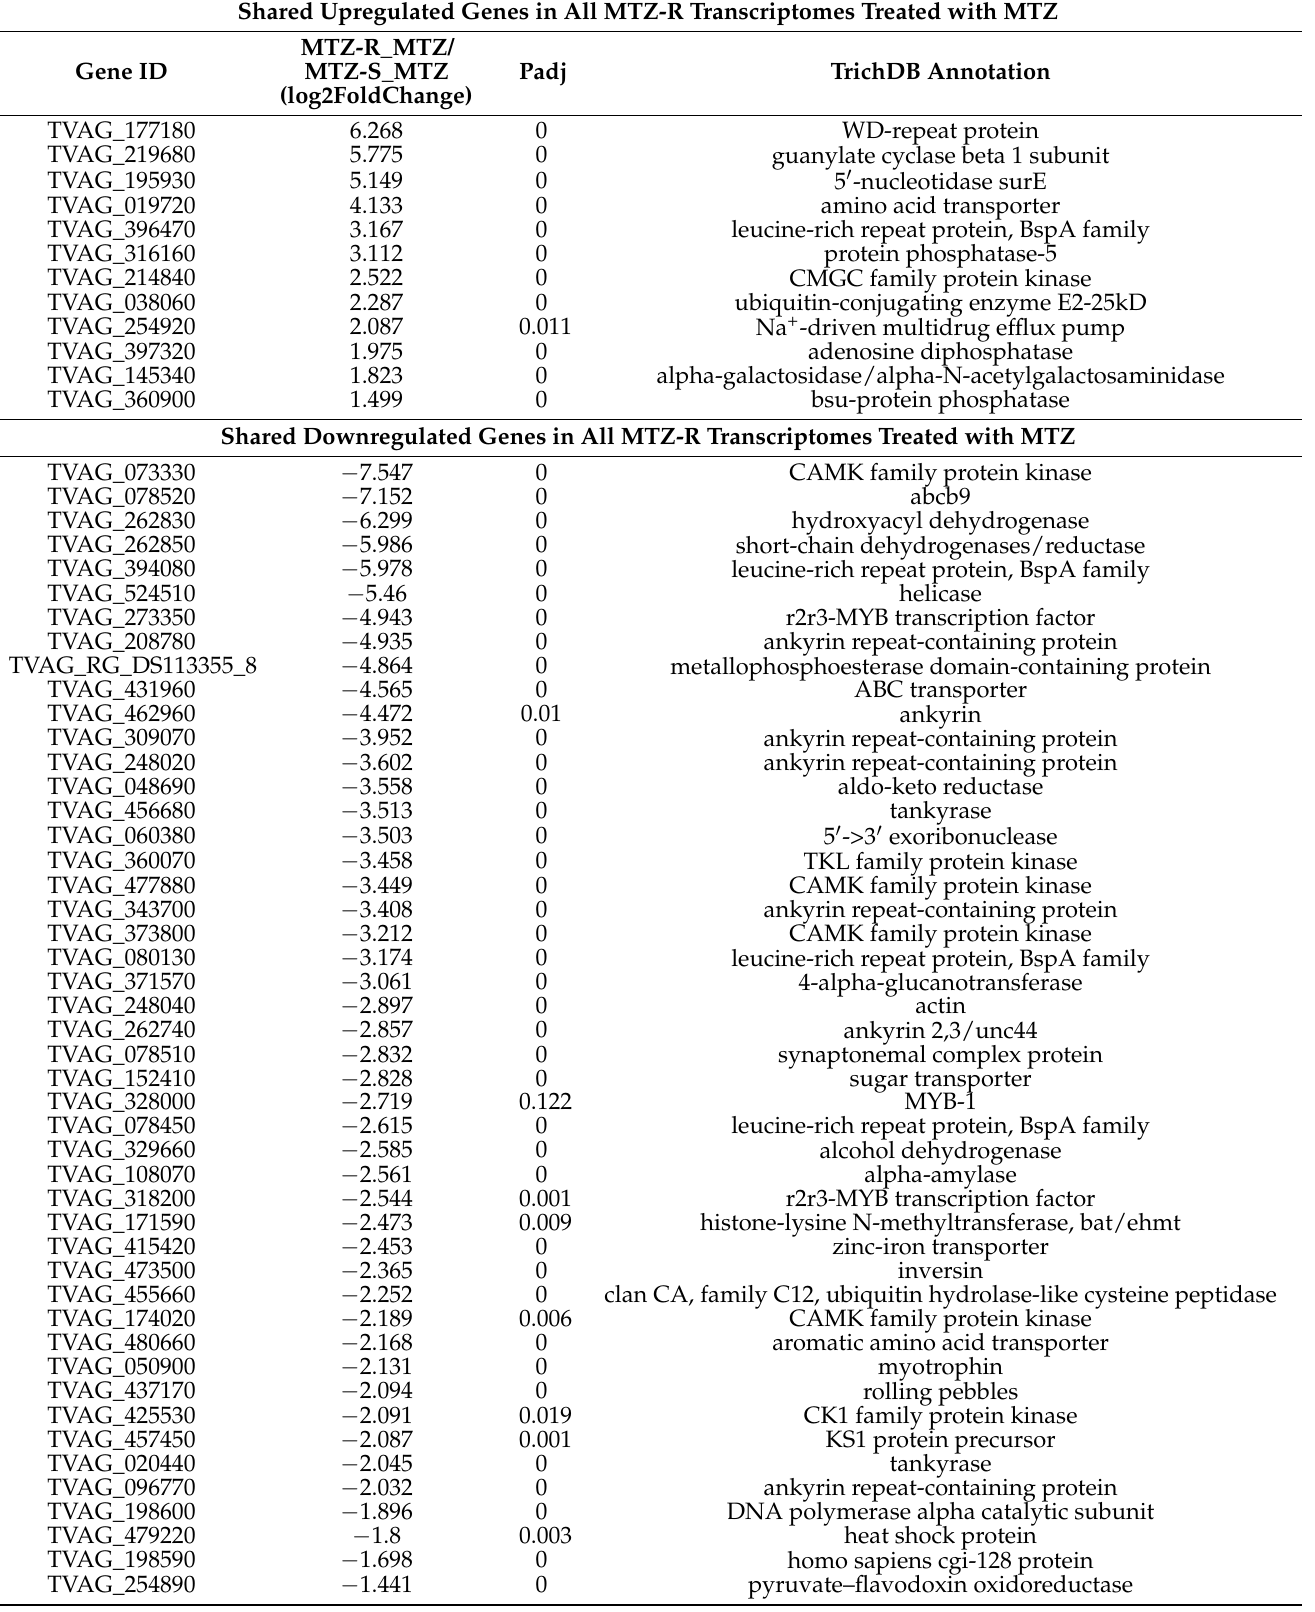
Table 2. Shared DEGs in all MTZ-R transcriptomes compared with those of MTZ-S in the presence of MTZ. Shared Upregulated Genes in All MTZ-R Transcriptomes Treated with